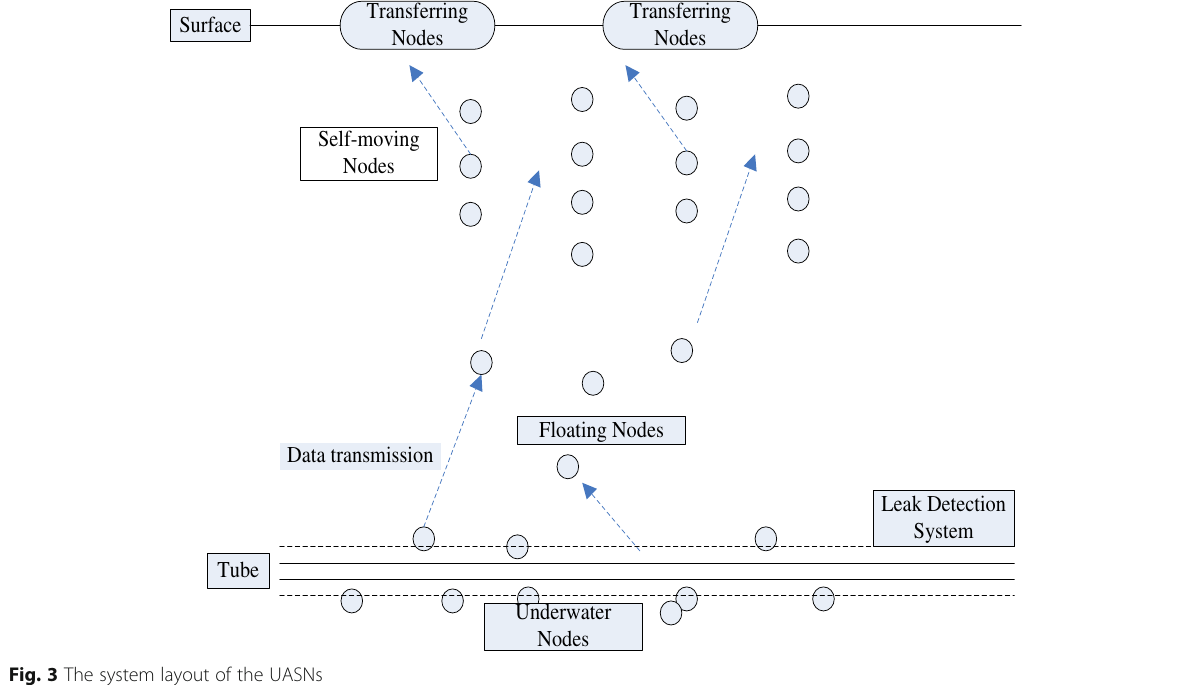
Fig. 3 The system layout of the